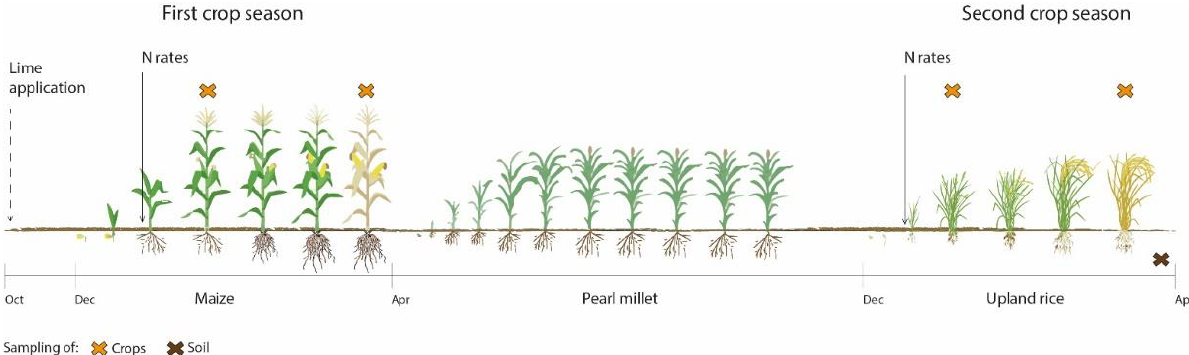
Figure 1. Scheme of N fertilizer and lime applications and sample collections during two growing seasons (maize and upland rice) of the experiment.